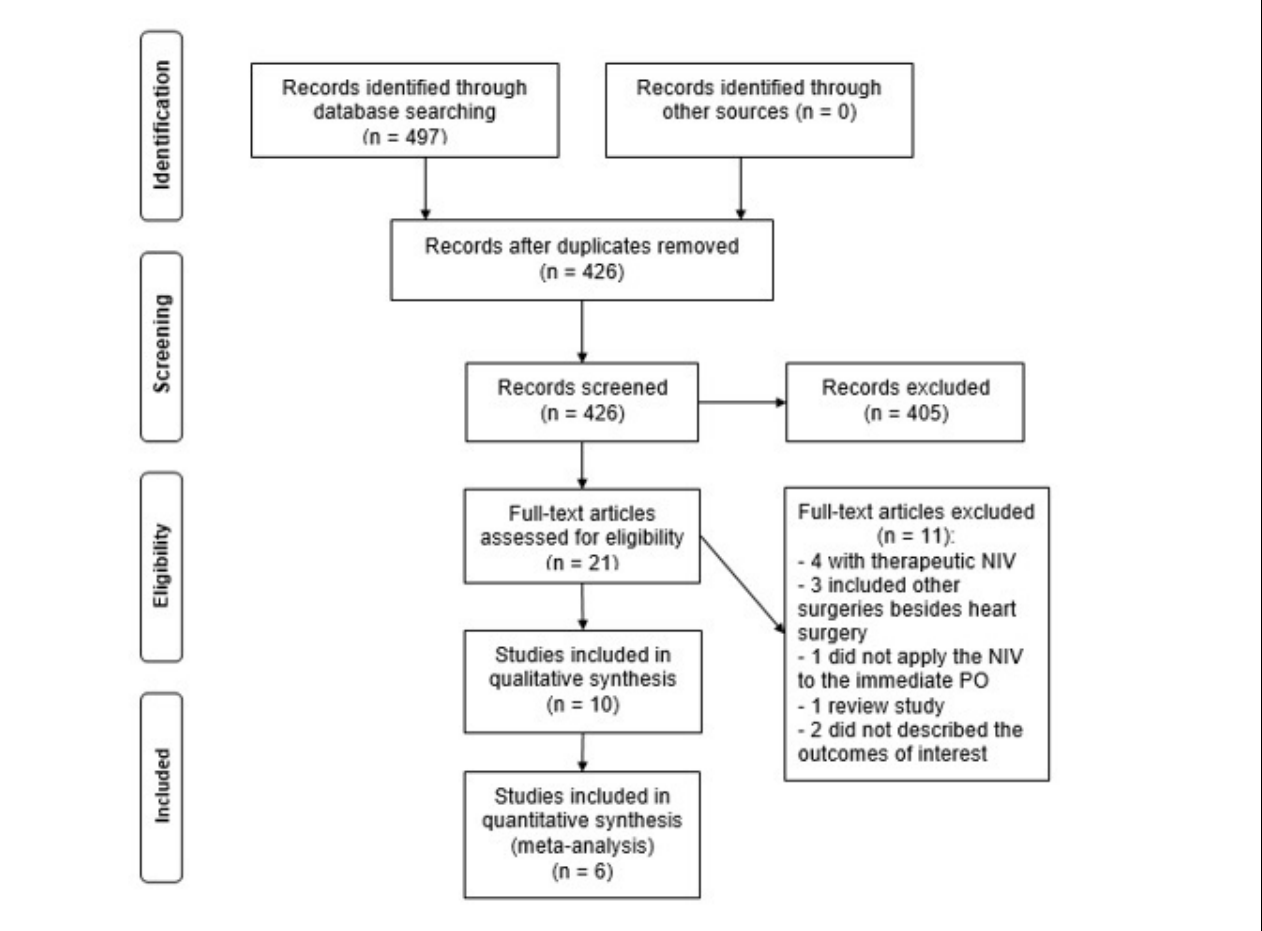
Fig. 1 – Flowchart of the studies included in the systematic review and meta-analysis. NIV=noninvasive ventilation.